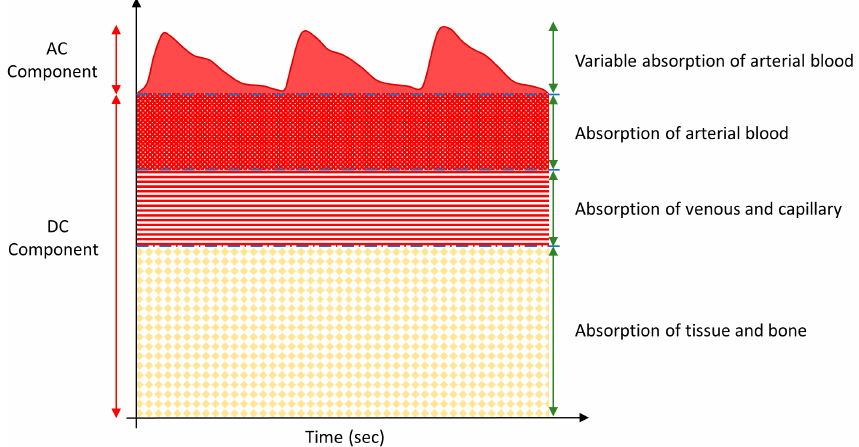
Figure 2. Schematic of light absorption in body tissues.